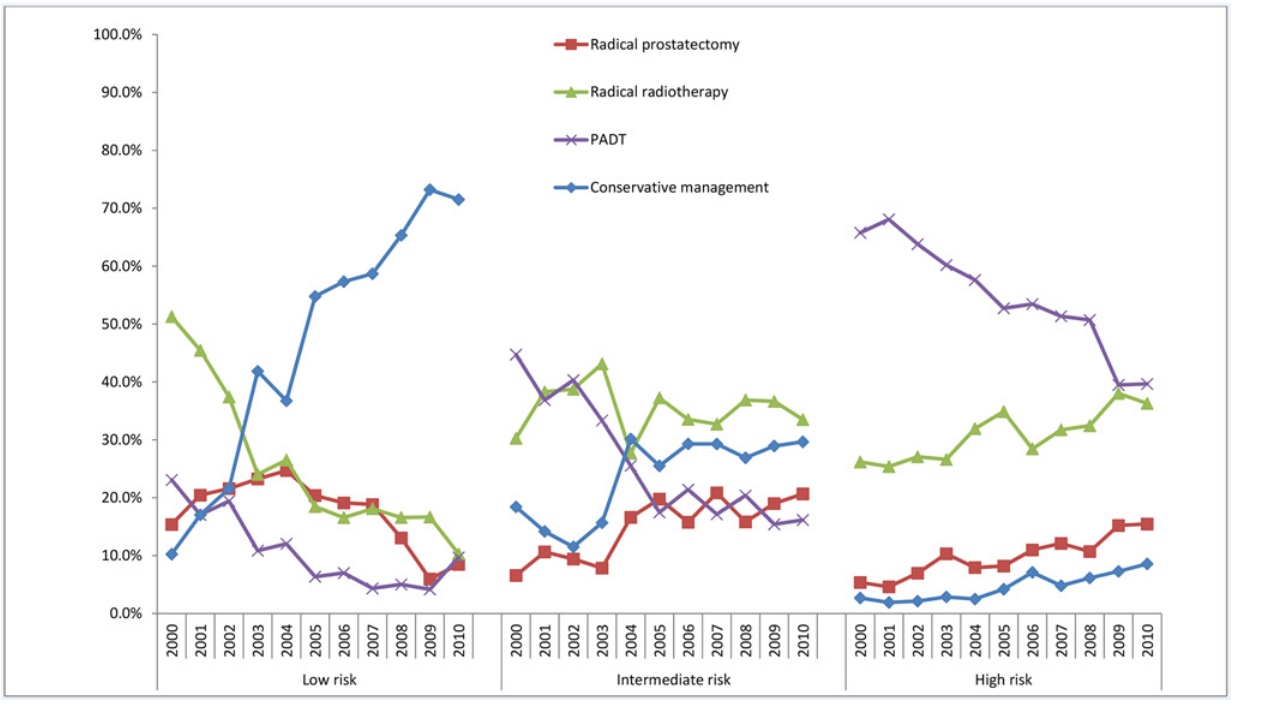
Fig 2. Proportions of men with non-metastatic cancer treated by different modalities and stratified by NICE risk group from 2000 –